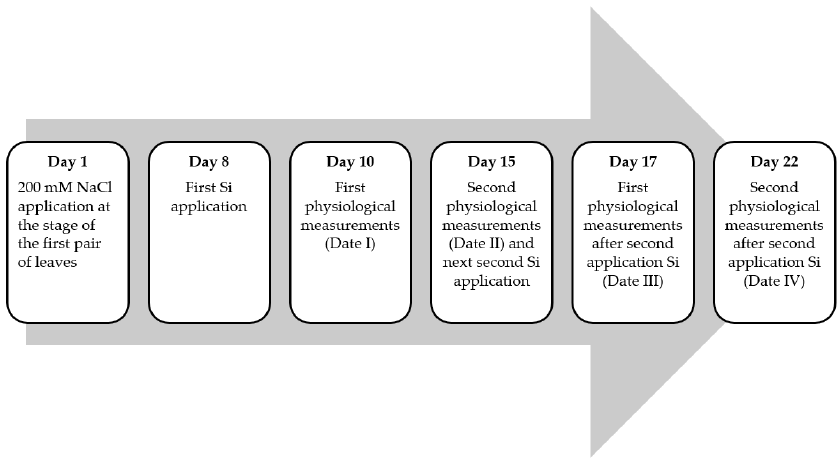
Figure 1. The scheme of the time of NaCl application, Si spraying, and physiological measurements in pot experiment.